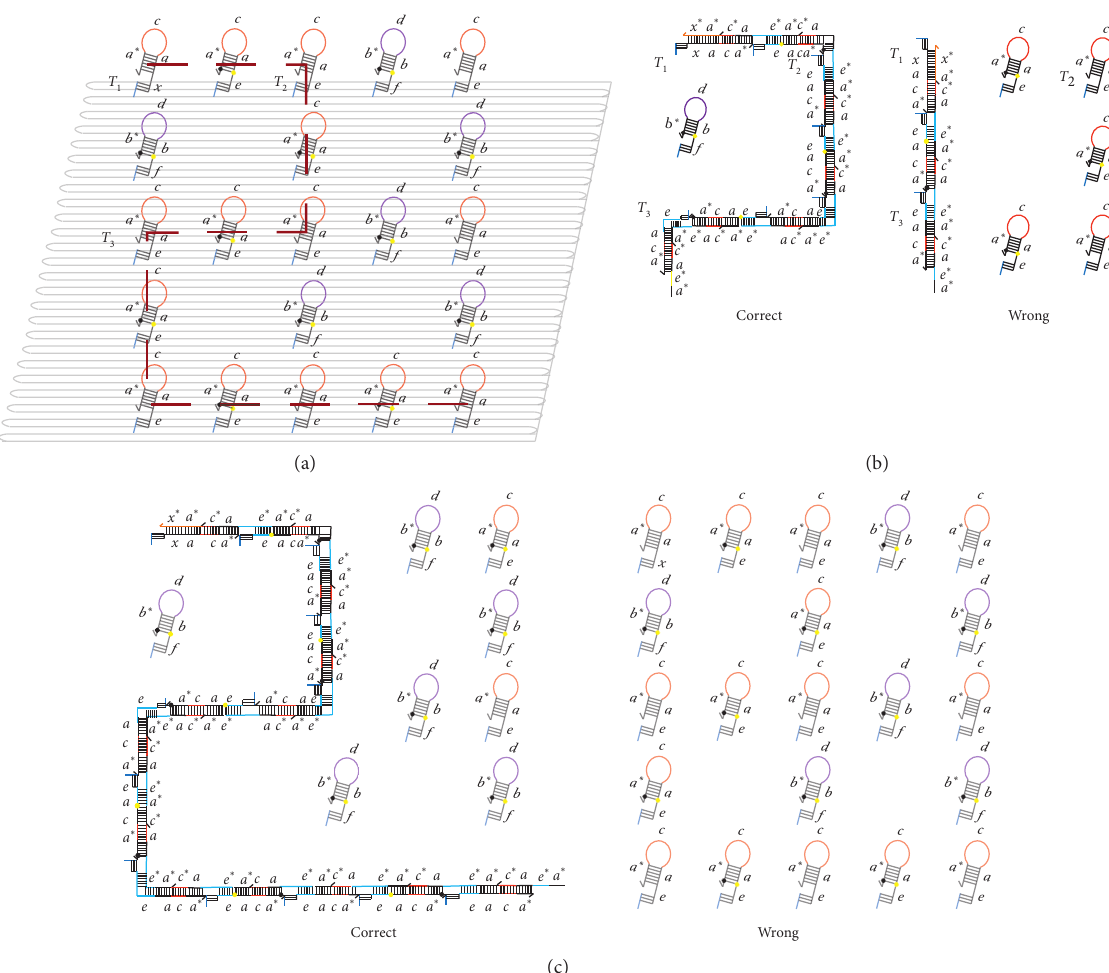
Figure 4: (a) Cipher pattern to be displayed on the origami base; (b) the correct and wrong ways to open the designed cipher diagram in the reaction; (c) origami base figure after adding cipher chain to